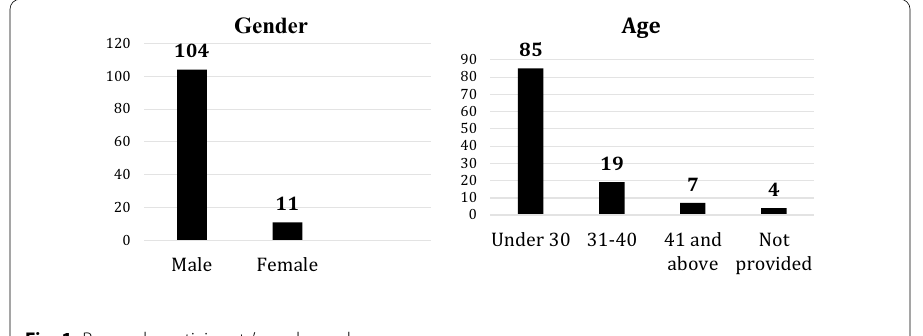
Fig. 1 Research participants’ gender and